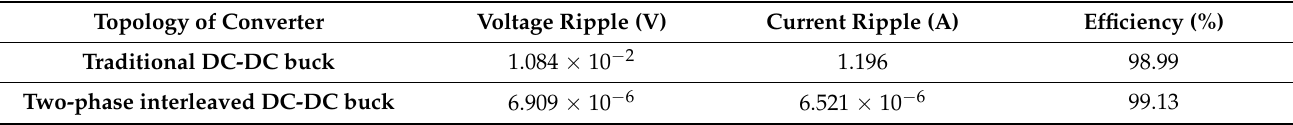
Table 4. Comparison table for non-isolated DC-DC converter